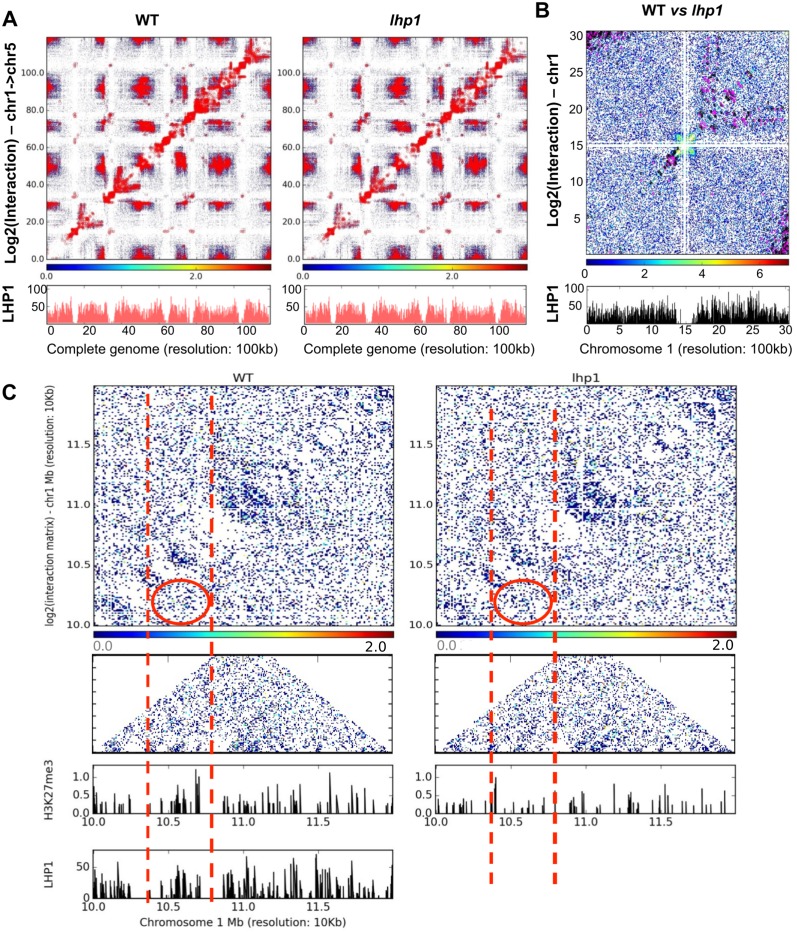
Genome topology is globally altered in the lhp1 backgorund.(A) 2D interaction map showing significant interactions in WT and lhp1. Highly significant interactions are marked as red dots in their corresponding boxes. The color scale represents log2 (interaction) values. Lower panel in red (marked “LHP1”) are peaks from the LHP1 WT ChIP-seq. The two LHP1 panels are identical as they correspond to LHP1 binding in WT. The second LHP1 panel is shown here to correlate this dataset with the Hi-C in the mutant. (B) A screenshot of zoomed 2D interaction map showing intra-chromosomal interaction and LHP1 binding region for Chromosome 1. Centromeric interactions in those regions are masked. WT specific interactions are marked as black dots and lhp1 specific interactions are marked as purple dots. The color scale represents the log2 (interaction), which is calculated against the background (taken as lhp1 mutant). Lower panel in black (marked “LHP1”) shows the peaks of LHP1 deposition in WT ChIP-seq. (C) 2D interaction map showing the loss of interaction in lhp1 when compared to the same region in WT (top panels). Lower panels show the loss of H3K27me3 in the same region. In red it is highlighted the region in WT where LHP1 and H3K27me3 co-occur, exhibiting interaction changes in lhp1 mutants, along with the loss of H3K27me3.